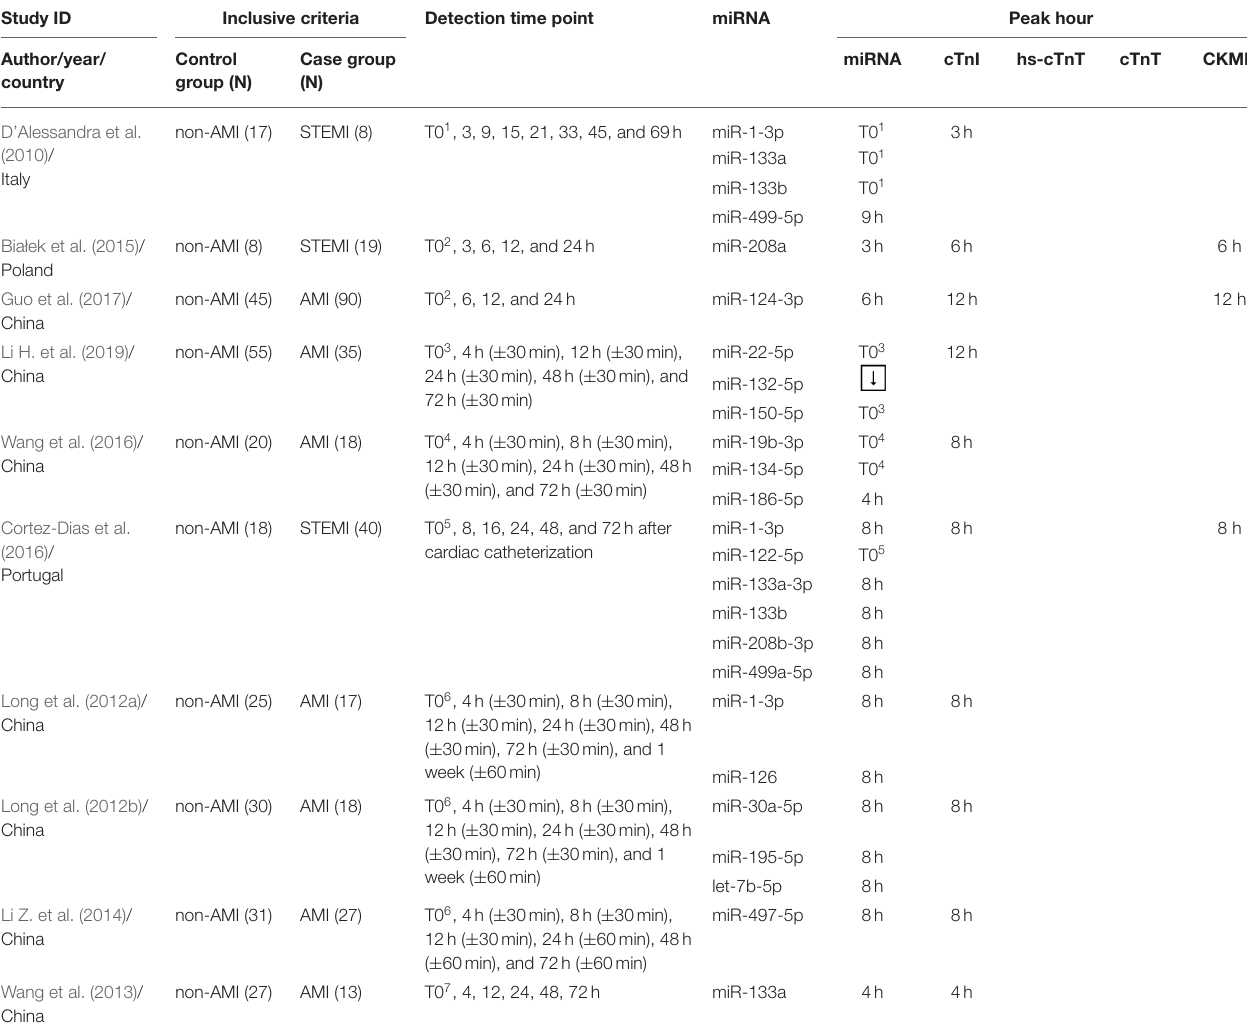
TABLE 1 | Peak hour comparison of miRNAs and conventional